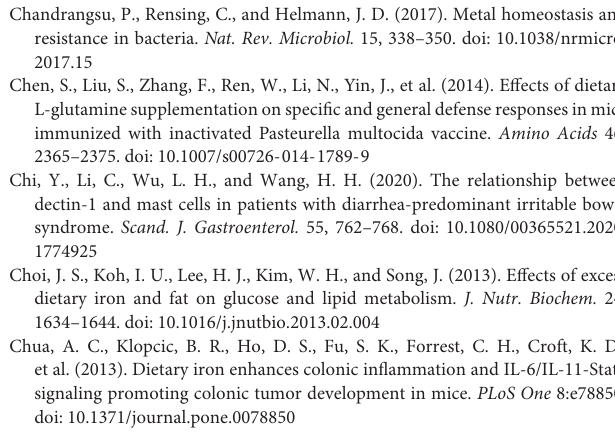
Supplementary Figure 2 | Dietary iron shifted gut microbiology. Venn diagram showed colonic shared and unique OTUs among different groups (A) . The rarefaction curve of colonic microbial in each group (B) . The relative abundance of species in the cecum at the species level was shown (C) . Cecal E. coli was similar among each group (D) . Ordinary one-way ANOVA or Kruskal–Wallis test was used for the statistical analysis among different groups. ∗ P <